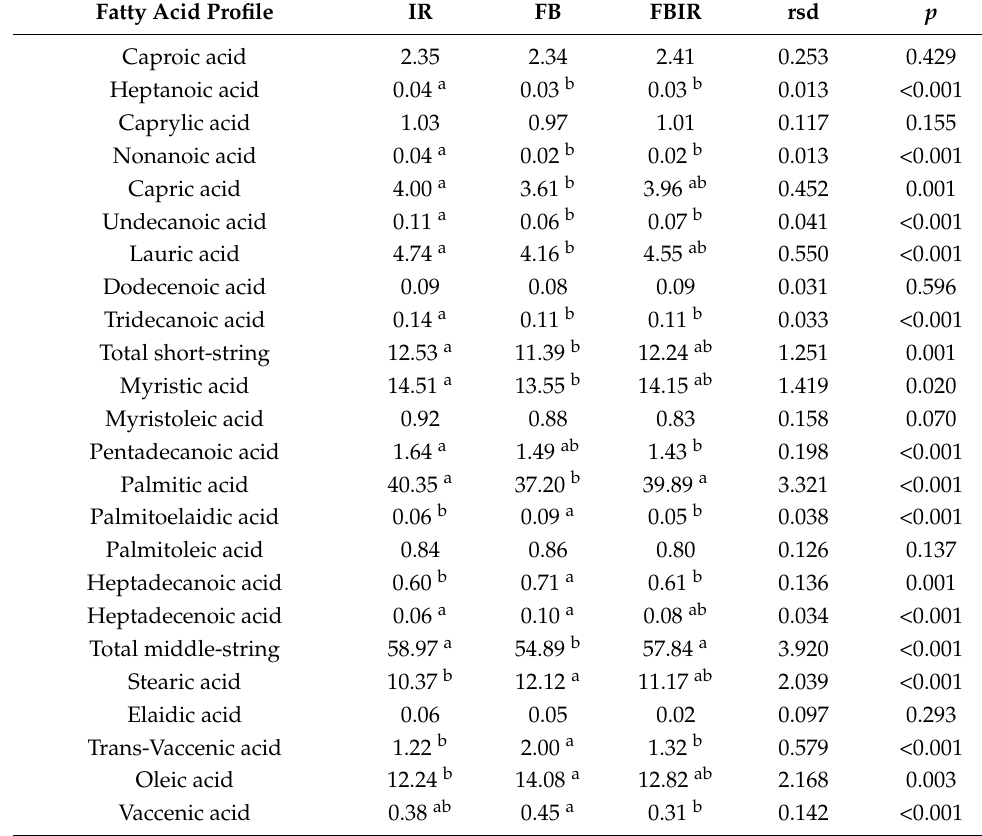
Table 7. Fatty acid profile (g 100 g − 1 FA) of milk according to the type of total mixed ration (TMR) offered to dairy